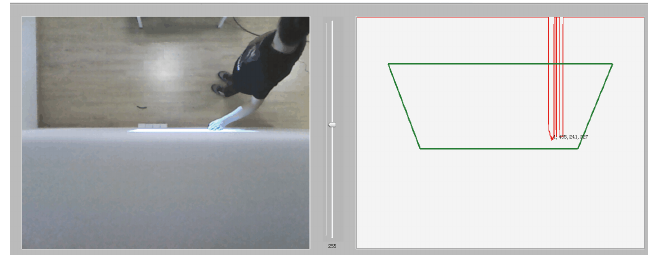
Figure 3: Gesture tracking and positioning effect without filter